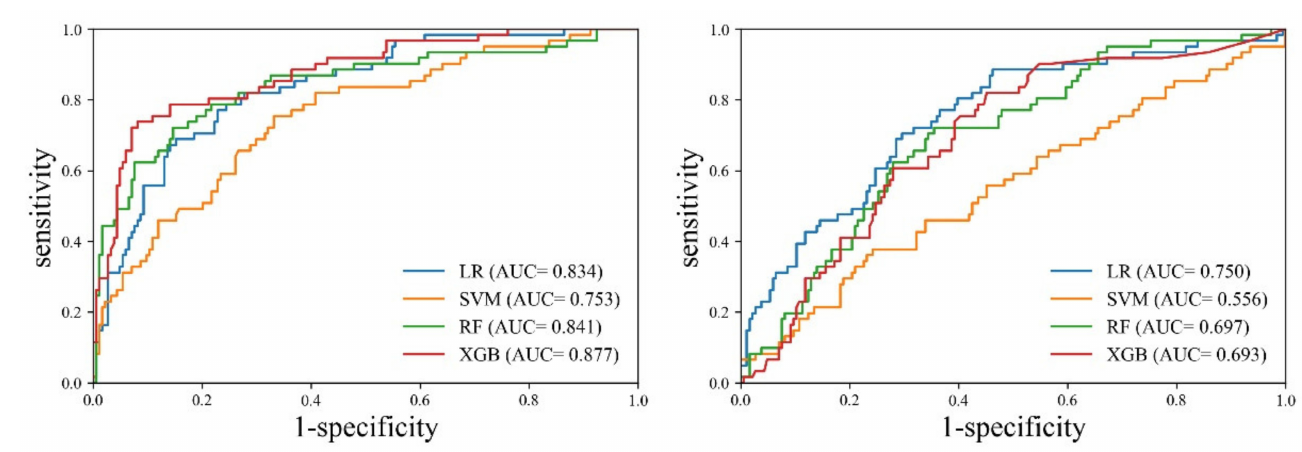
Figure 5. Comparison of ROC curves among different machine learning models for the identification of sarcopenia. The left graph presents the ROC curves of the entire muscle, where XGB has the highest AUC. The right graph shows those of the erect spinae muscle, where LR has the highest AUC. LR, logistic regression; SVM, support vector machine; RF, random forest; XGB, extreme gradient boosting; ROC, receiver operating characteristic; AUC, area under the